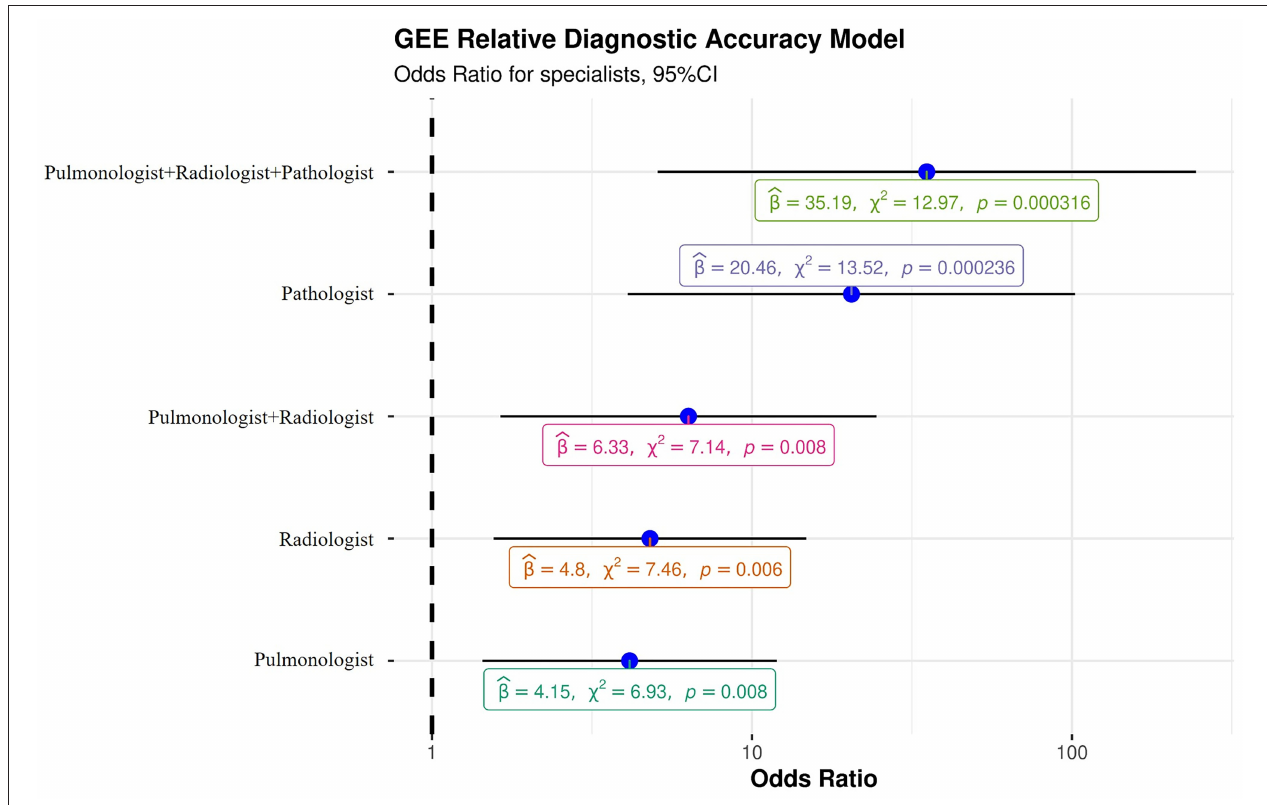
FIGURE 3 | Generalized estimating equation representing the probability of a correct diagnosis for single specialists and for the multidisciplinary team. β , beta, “estimate”; χ 2, chi-squared, “regression coefficient.”